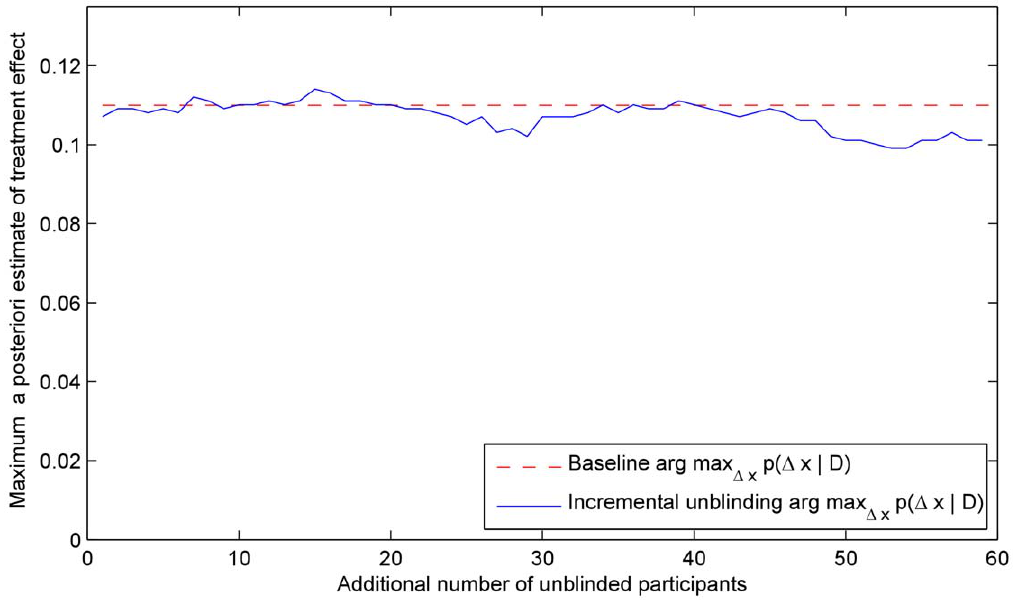
Figure 9. Experiment 4. The maximum a posteriori estimate of the treatment effectiveness as the participants assigned to both the treatment and the control groups are progressively unblinded (compare with the previous, asymmetric blinding experiment and Figure 7). As before, the proposed